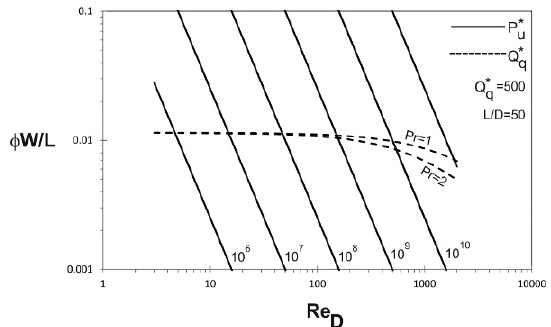
Figure 15. Influence of the Prandtl number on the variation of group with the Reynolds number (laminar regime and constant heat-flux